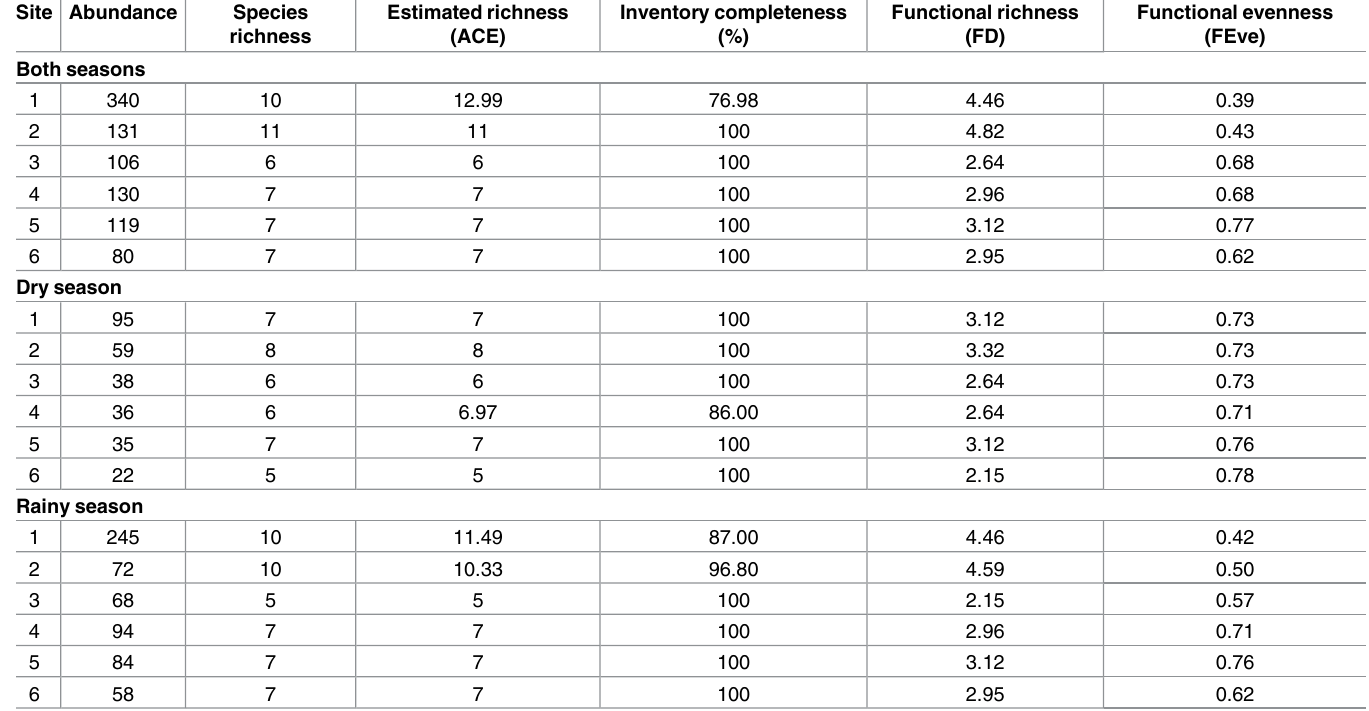
Table 4. Cumulative parameters of bat communities. Data correspond to six samplingsites in the Huastecaregion, Hidalgo,Mexico. Site Abundance Species